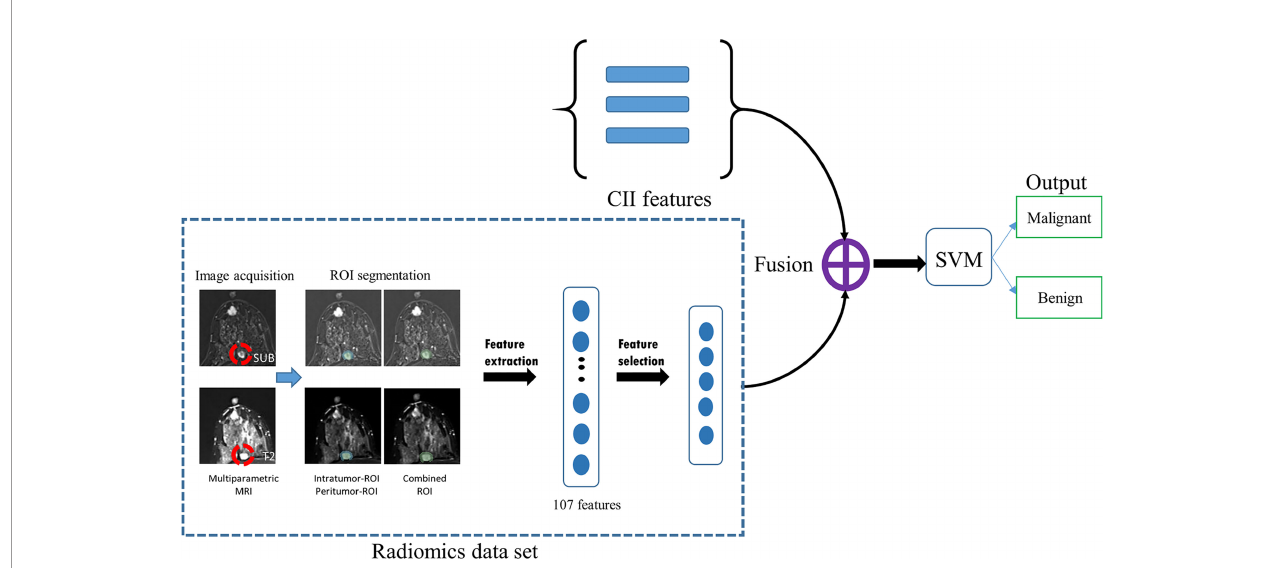
FIGURE 2 | Schematic fl owchart of the fusion model developed in this study. Radiomics features were extracted from MRI data using three regions-of-interest (ROIs; intratumor, peritumor, and combined). After the feature selection process, the selected radiomics features were concatenated with three CII features and used to train a support vector machine (SVM) for distinguishing between malignant and benign additional lesions. SUB, images obtained by subtracting pre- from the fi rst postcontrast image; T2, T2-weighted image; MRI, magnetic resonance imaging, SVM, support vector machine; CII, clinical imaging